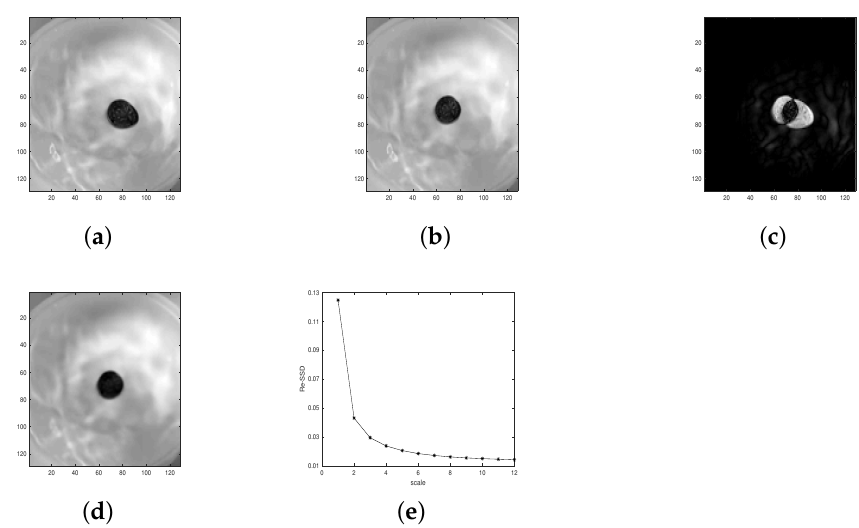
Figure 13. Registration result of Algorithm 2 on image pairs of Underwater coin. ( a ) T ( · ) . ( b ) D ( · ) . ( · ) . ( e ) Re − SSD change (Underwater coin) with scale number. ( c ) | T − D | . ( d ) T ◦ ˆ h K M